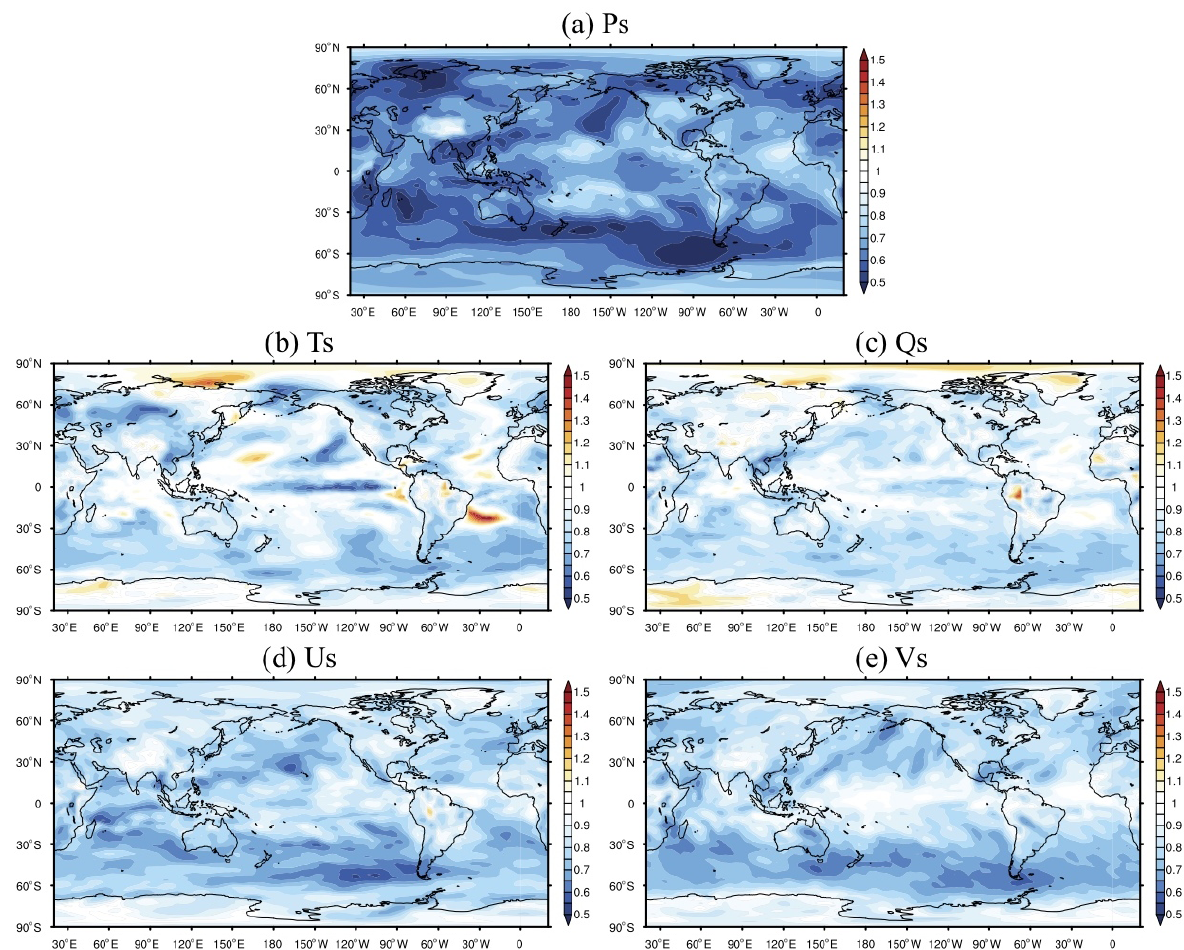
Figure 5. The distribution of the RMSE ratio (ada_fv/ctl) of (a) surface pressure P s , (b) surface temperature T s , (c) surface specific humidity Q s , (d) surface zonal wind U s , and (e) surface meridional wind V s . The RMSE ratios are calculated with the data of the first month